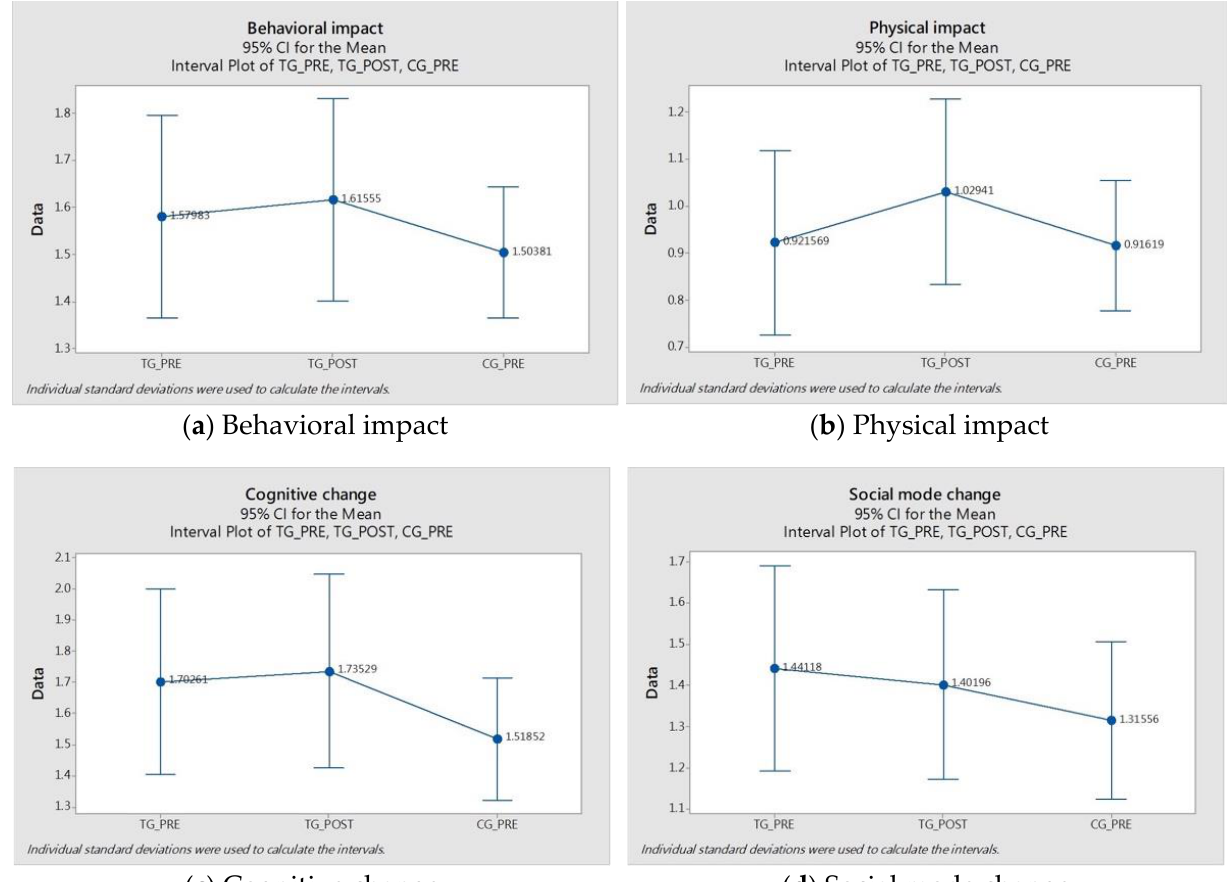
Figure 13. ( a ) Interval plot for Behavioral impact of TG_PRE, TG_POST, and CG; ( b ) Interval plot for Physical impact of TG_PRE, TG_POST, and CG; ( c ) Interval plot for Cognitive change of TG_PRE, TG_POST, and CG; ( d ) Interval plot for “Social mode change” of TG_PRE, TG_POST, and CG.